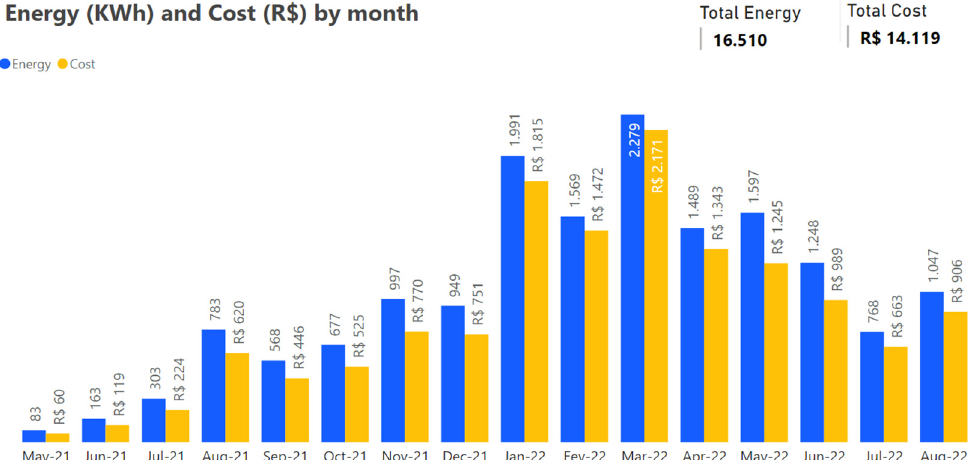
Figure 2. Energy consumption and costs of Operation 2 (light vehicles).